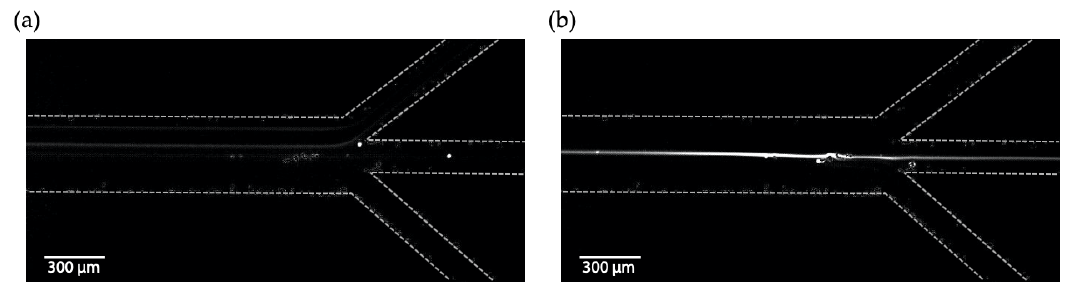
Figure 8. Acoustic focusing of 10 µm fluorescent particles. ( a ) Without acoustics the particles are not focused (hence hard to see in the fluorescent image) and do exist in both the centre and side outlet channels. ( b ) With the acoustics the particles are focused along the centre-line of the resonance channel and enriched in the centre outlet channel. The dashed lines show the borders of the channels.